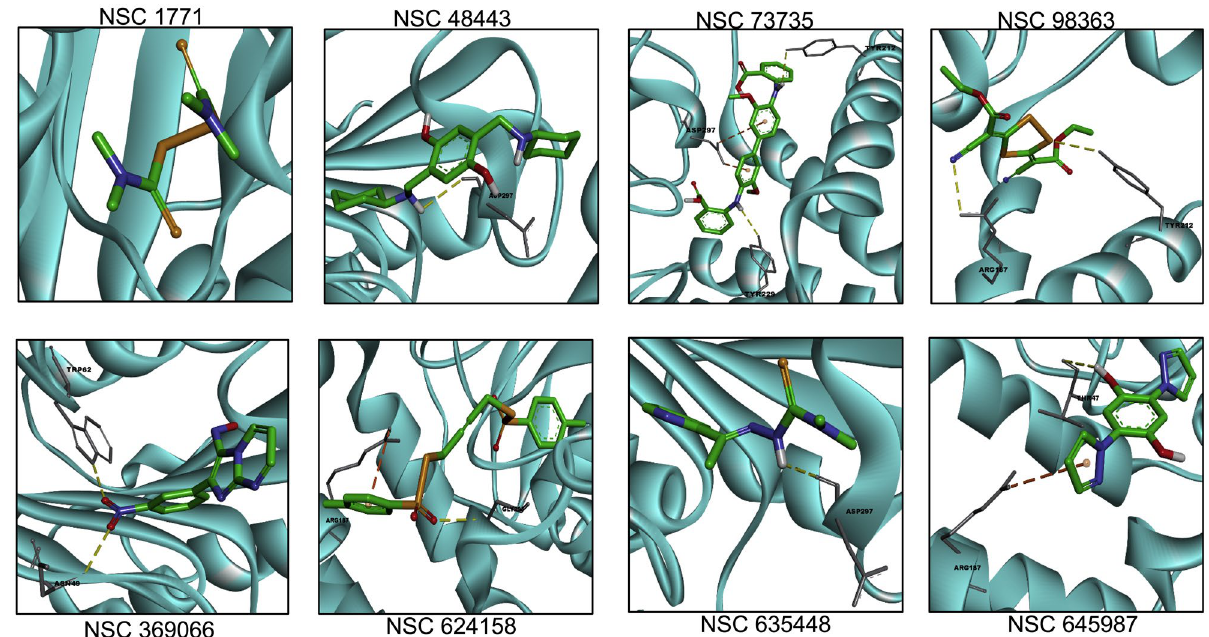
Figure 6. Molecular docking of the identified primary hits in HSAT structure from S. aureus . Docking of the identified primary hits in the three-dimensional structure of S. aureus HSAT protein is shown. The hydrogen bonds and cation-pi bonds have been shown as yellow dotted and orange dotted lines, respectively. The residues involved in these interactions are also labeled in the